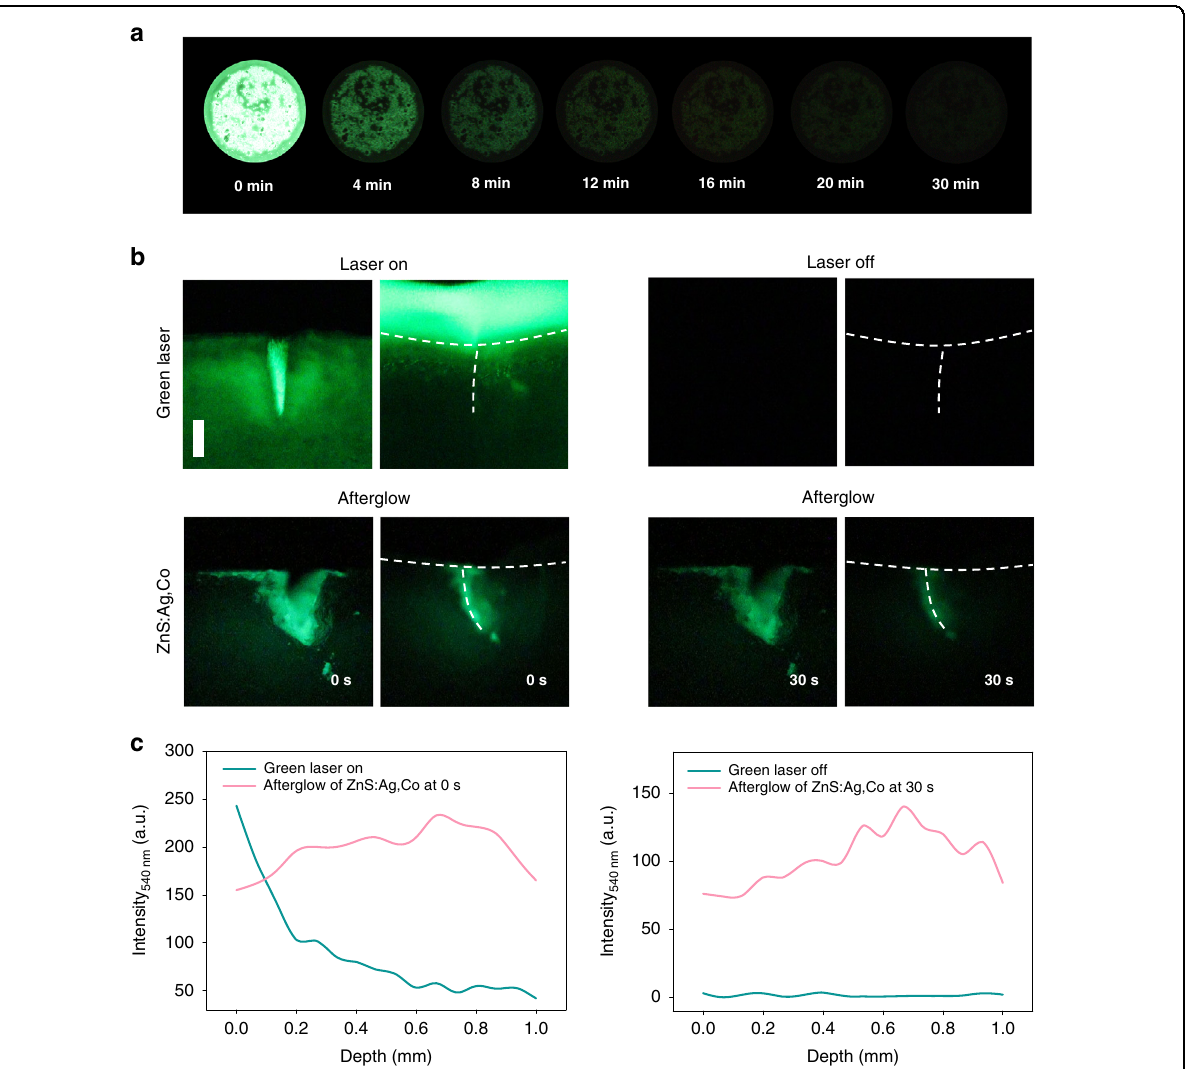
Fig. 4 Green afterglow image of ZnS:Ag,Co particles. a The afterglow image of ZnS:Ag,Co particles obtained by the charge-coupled device (CCD) camera at 4, 8, 12, 16, 20, and 30 min after irradiation with a 365 nm UV lamp for 30 s. b The propagation of green light (upper) and light converted by ZnS:Ag,Co particles (lower) in the incision of porcine skin (scale bar = 1 mm). After irradiating the open wound with a light source, the incision site was closed and fl uorescent images were taken when the green laser was turned (left) on or (right) off. Afterglow images of ZnS:Ag,Co particles were taken at 0 s and 30 s after UV light irradiation. Dashed lines indicate the incised surface of the porcine skin. c The green fl uorescence pro fi le in the skin depth direction of porcine tissue treated with a green light or AL of ZnS:Ag,Co particles (left: laser-on green light and the AL of ZnS:Ag,Co particles at 0 s; right: laser-off green light and the AL of ZnS:Ag,Co particles at 30